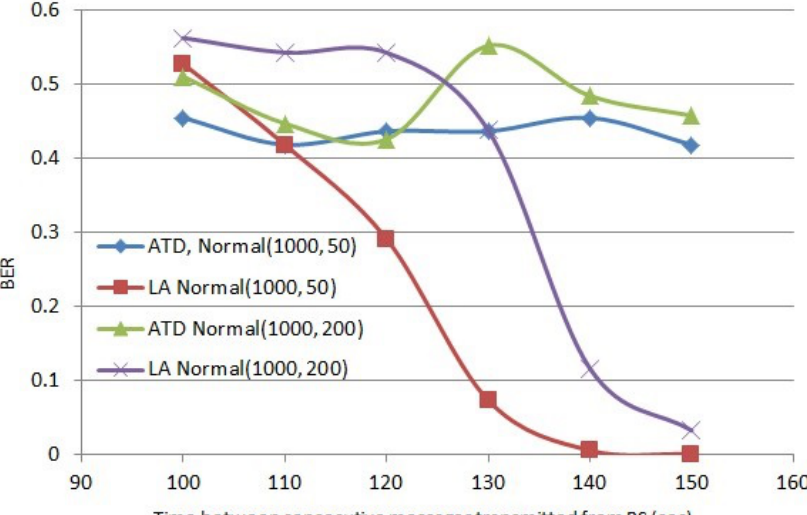
Figure 7. Speed of convergence for the